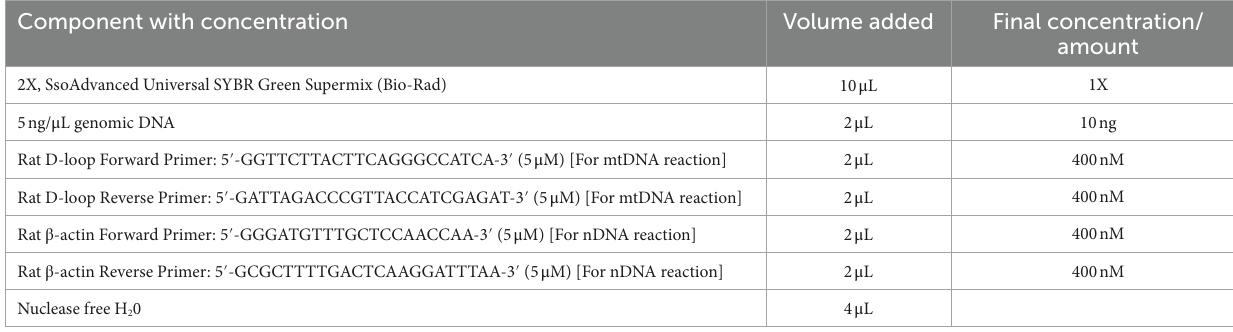
TABLE 1 Preparation of 20 μ L reaction mixture for real-time PCR. Component with concentration Volume